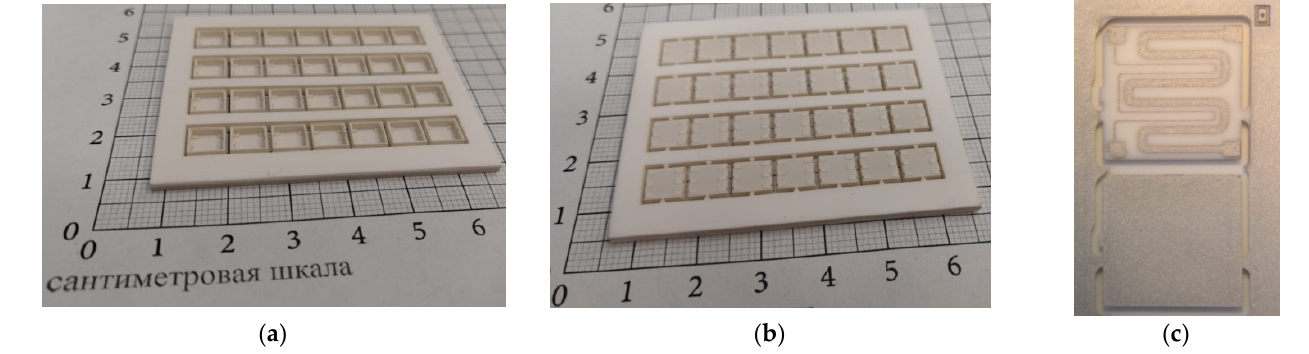
Figure 3. Image of bottom parts of packages and platinum heater fabricated in a 48.0 × 60.0 × 2.0 mm substrate with laser micromilling: ( a ) substrate with raw 7 × 4 bottom part of package—top view; ( b ) substrate with raw of 7 × 4 bottom part of package—backside view; ( c ) heater view before and after metallization laser ablation according to a 3D model of heater and thermistor metallization topology.